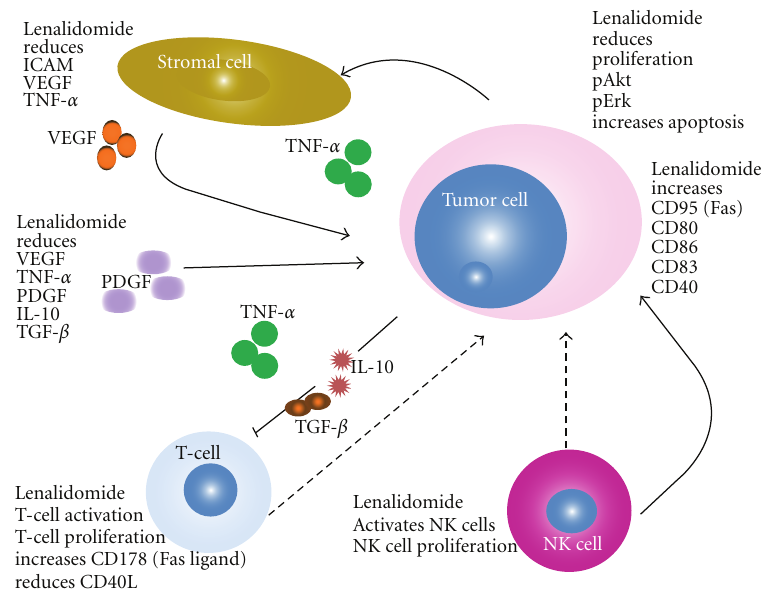
Figure 2: Action of